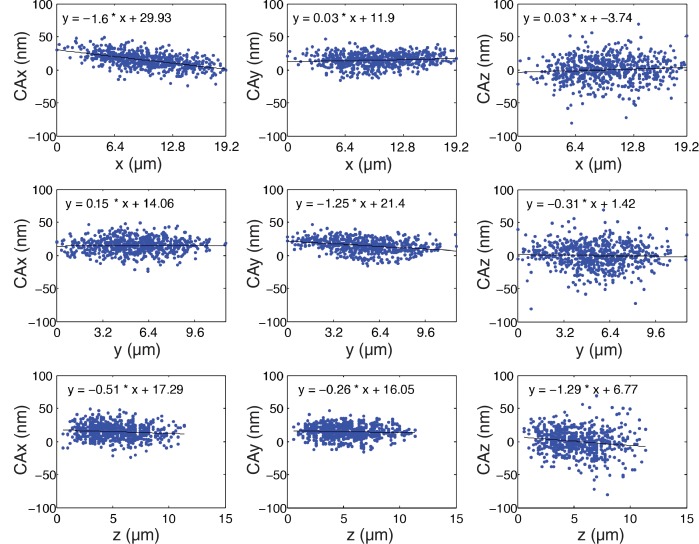
Measurement of CA of the microscope optics.Plots of CAx, CAy, and CAz versus x, y, and z for separation between Hec1-9G3-GR in samples fixed with PFA and mounted with Prolong Gold.